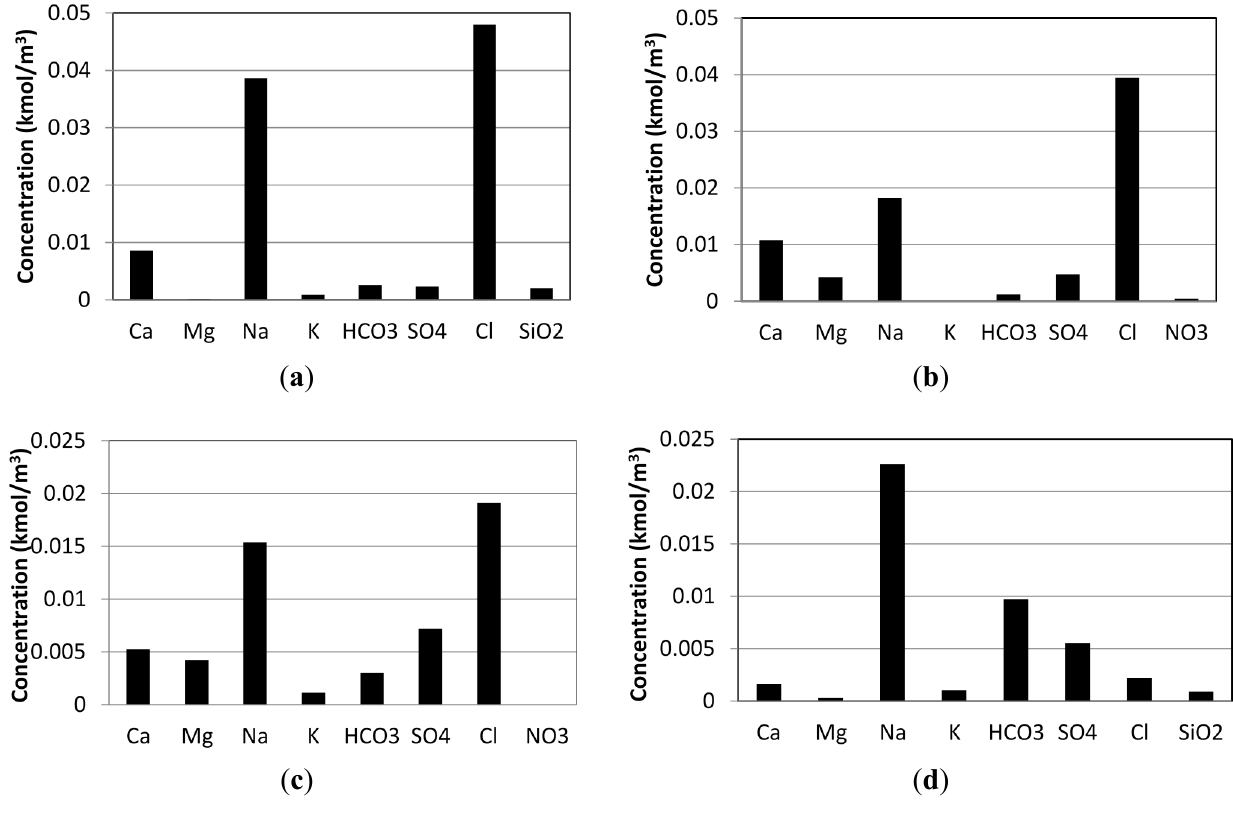
Figure 8. Compositions of groundwater corresponding to case studies ( a ) Tuwa 5 spring in Gujarat, India [39]; ( b ) Site A on Najd Plateau, Saudi Arabia [41]; ( c ) intercalaire